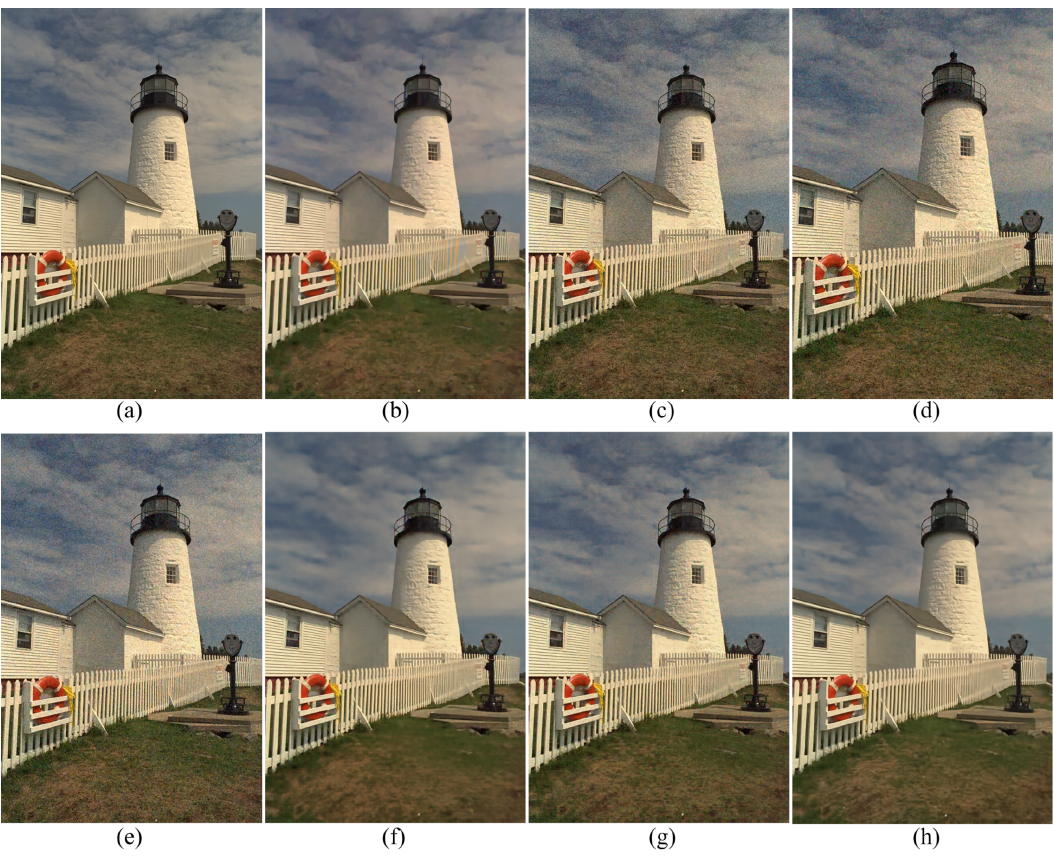
Figure 4. Reconstruction results for the Kodak number 19 image with noise levels σ R = 19.67, σ G = 12.48 and σ B = 13.67. ( a ) Original, ( b ) ADMM, [28] ( c ) SEM, [14] ( d ) DNetB, [15] ( e ) DNetX, [15] ( f ) DIP, [19] ( g ) proposed and ( h ) proposed + BM3D.